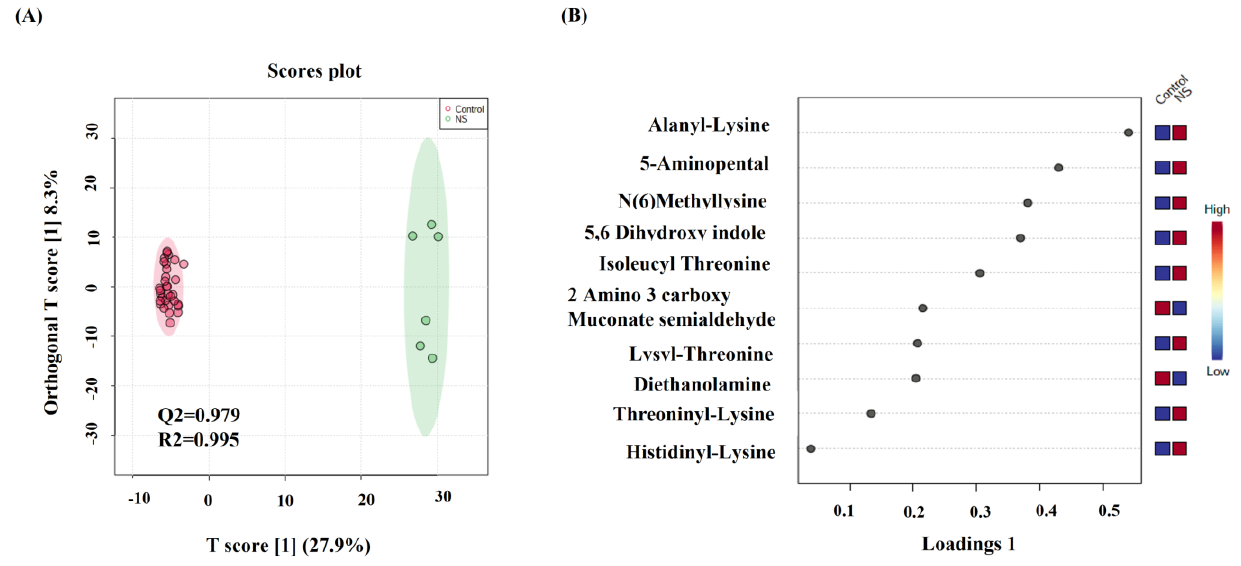
Figure 1. ( A ) Orthogonal partial least square discriminant analysis (OPLS-DA) score plot shows clear clustering and separation between patients with NS (n = 6) and healthy control (n = 33) representing the level of global metabolic differential expressions in NS compared to control. ( B ) The loading plot shows the regulation of metabolic expression of metabolites between NS and control.